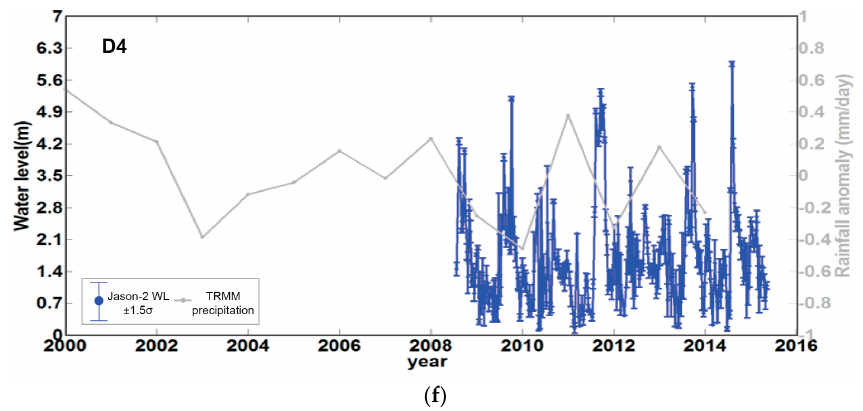
Figure 6. Time series of rainfall rate anomaly and WL measured by multiple sensors at: ( a ) Xiaowan Dam; ( b ) Jinghong Dam; and ( c – f ) the four measurement sites in the downstream (D1–D4, Figure 2). The red broken line in all panels is the measurement from RS images, the blue line is from Jason-2, and the green line is from Envisat. These WL estimates, regarding WGS84 ellipsoidal height, refer to the left ordinate in meter. There is also annual rainfall rate anomaly plotted as gray line shown in the background of each panel, which refers to the right ordinate. Positive (negative) anomaly values means the precipitation of that year is more (less) than the long-term average rainfall rate.